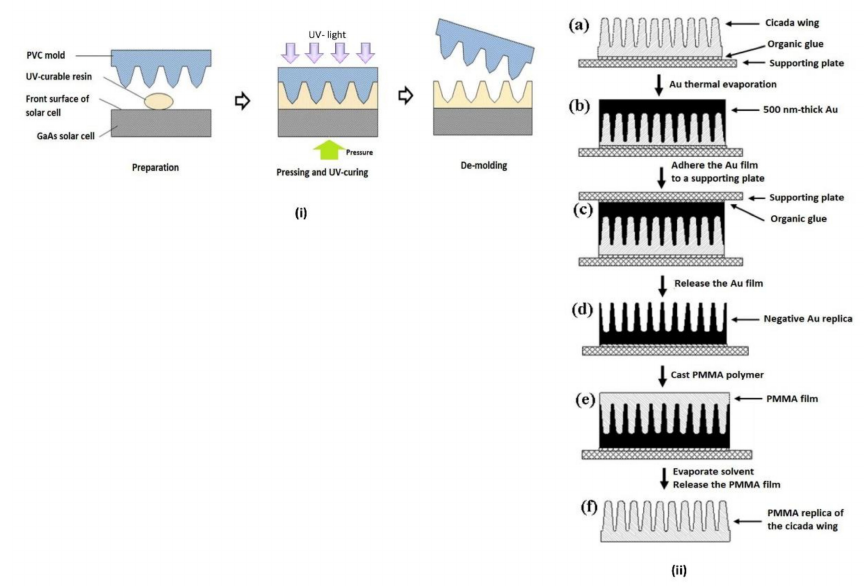
Figure 13. ( i ) Illustration of various steps in the preparation of moth’s eye pattern using nano-imprint lithography methodology. Reprinted with permission from Ref. [93]; Copyright 2011, Elsevier ( ii ) Stepwise illustration of bio-replication method with cicada wing as a template. ( a ) Cicada wing structure. ( b ) Depositing Au on the Cicada wing structure through thermal evaporation. ( c ) Adhering the Au film to the supporting plate. ( d ) Releasing the Au plate to obtain the Au mold. ( e , f ) Replicating the cicada wing structure on the PMMA film through prepared Au mold. Reprinted with permission